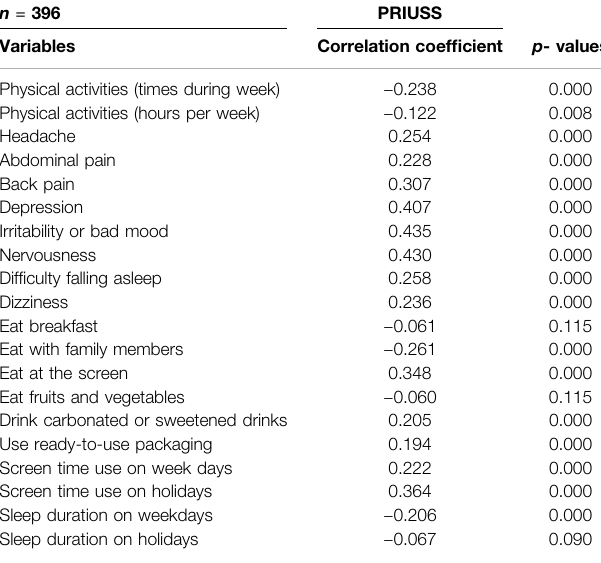
TABLE 2 | Correlation of PRIUSS total scores with subjective health complaints and healthy lifestyle